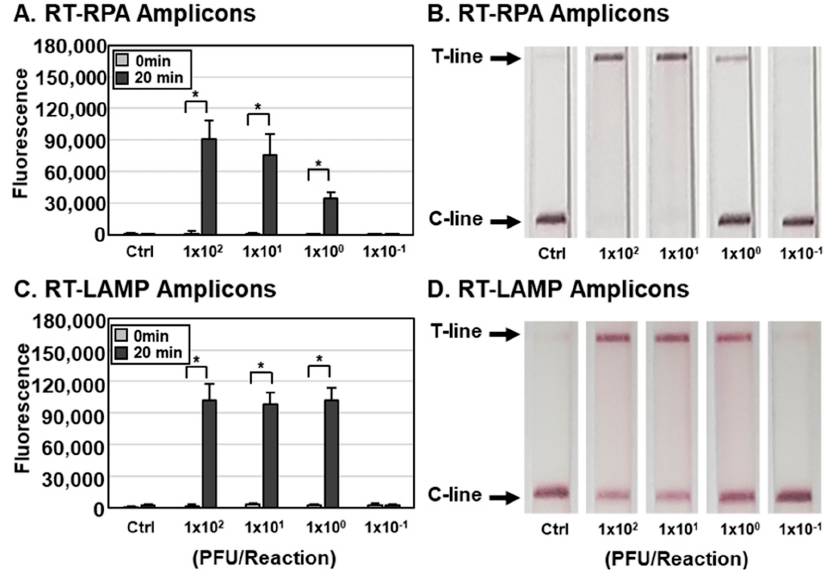
Figure 4. Sensitivity of the DETECTR assay for IBV. (A-D) Different concentrations of IBVs (1.0 × 10 − 1 to 1.0 × 10 4 PFUs per reaction) were used to amplify viral nucleic acids using either RT-RPA ( A , B ) or RT-LAMP ( C , D ) with primer sets specific for the IBV HA gene. RT-RPA and RT-LAMP amplicons were detected by DETECTR combined with fluorescence ( A , C ) or lateral flow ( B , D ) assays using gRNAs targeting the IBV HA gene. The fluorescence signals of DETECTR on RT-RPA or RT-LAMP amplicon were saturated within 20 min. Lateral flow assay results were assessed 2 min after inserting the strip into the sample. Values are presented as means ± s.d (error bars) ( n = 3 replicates; * p < 0.05 between samples, two-sample t -test). C-line, control line; T-line, test line; Ctrl,